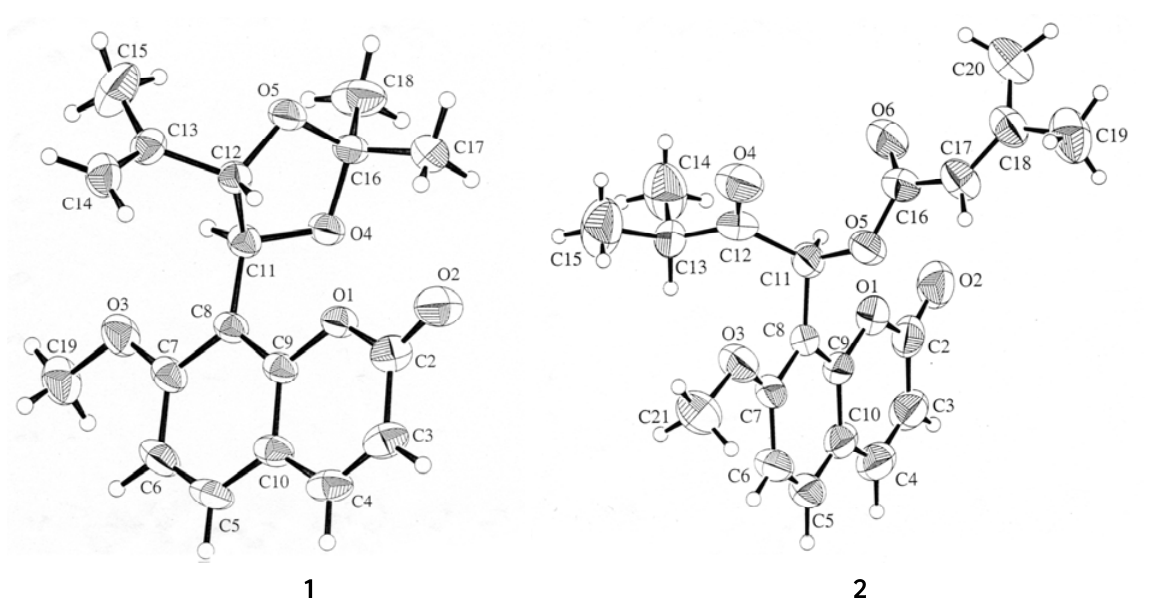
Figure 2. X-ray diffraction analysis of compounds 1 and 2